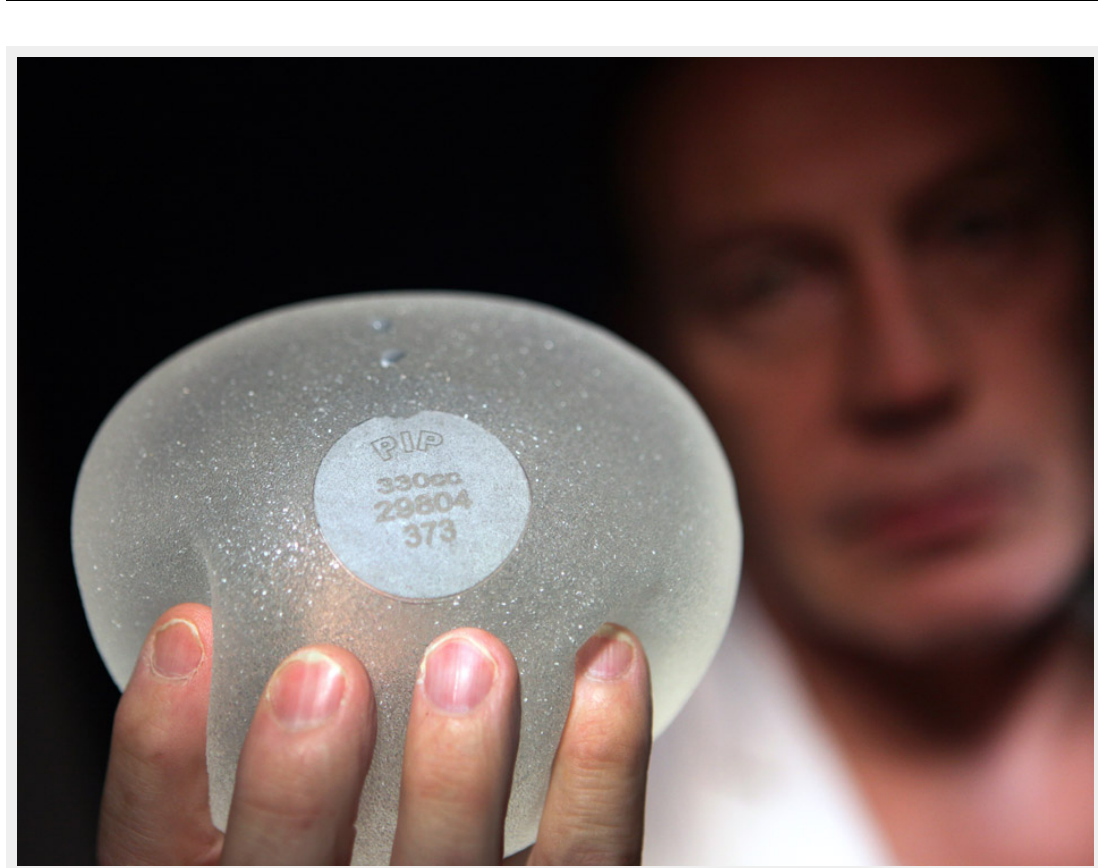
Figure 1 Silicone gel filled silicone rubber breast implant, manufactured by the French company Poly Implant Prosthese (PIP). © Sébastien Nogier / AFP. Reprinted with permission.